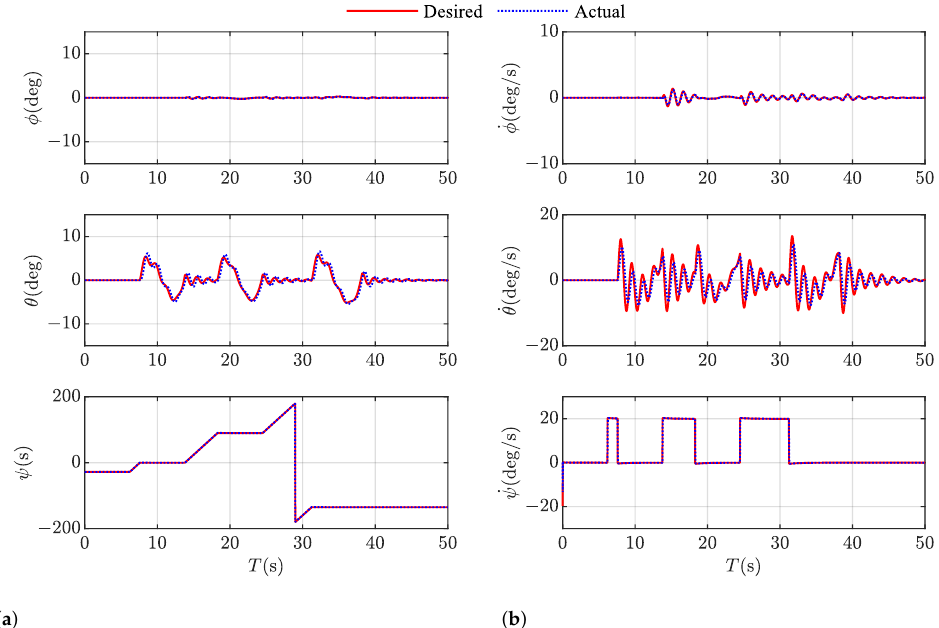
Figure 12. Attitude tracking in the simulation: ( a ) attitude angle tracking response; ( b ) attitude angle velocity tracking response.